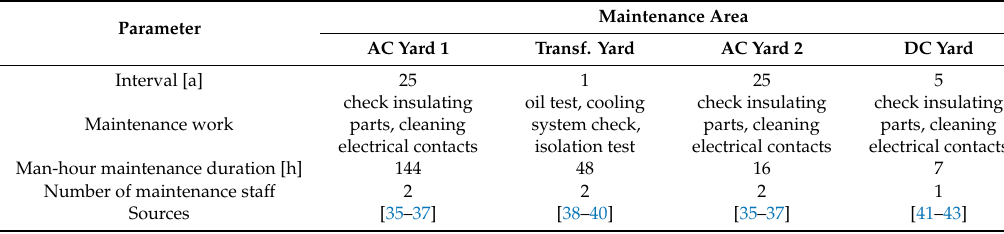
Table 4. Maintenance work and duration for di ff erent maintenance